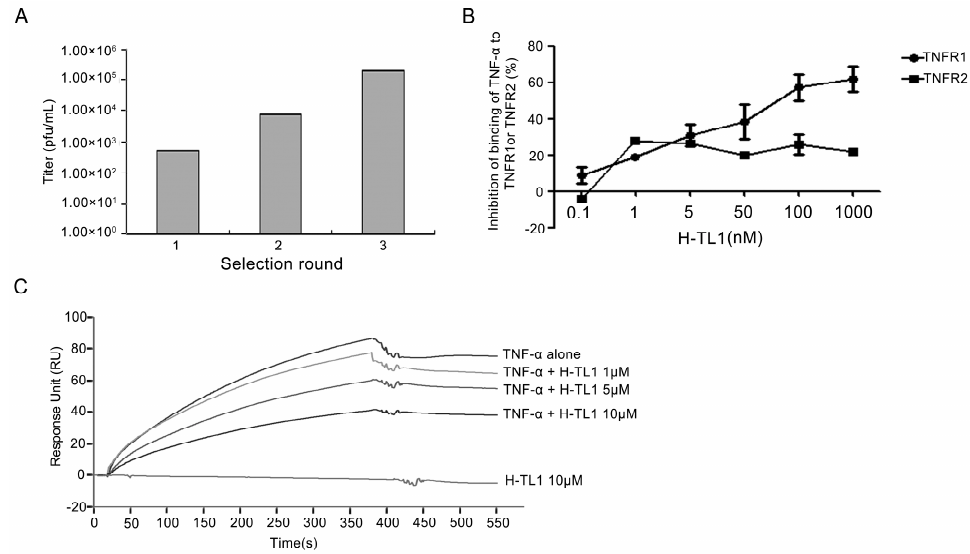
Figure 1. Biopanning and identification: ( A ) The titer increase of specifically bound phages after each selection; ( B ) ELISA assay showing that H-TL1 obviously inhibits the binding of TNF- α with TNFR1, but had little impact on TNF- α /TNFR2 interactions. Values represent means ± SEM ( n = 3); and ( C ) SPR analysis indicating that H-TL1 inhibits the association of TNF- α with sensor chip-immobilized TNFR1.